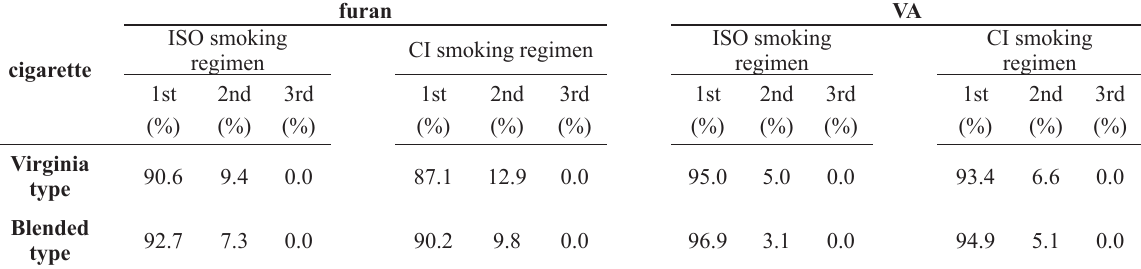
The trapping efficiency of furan and VA in vapor phase of mainstream cigarette smoke under ISO and CI smoking regimens.